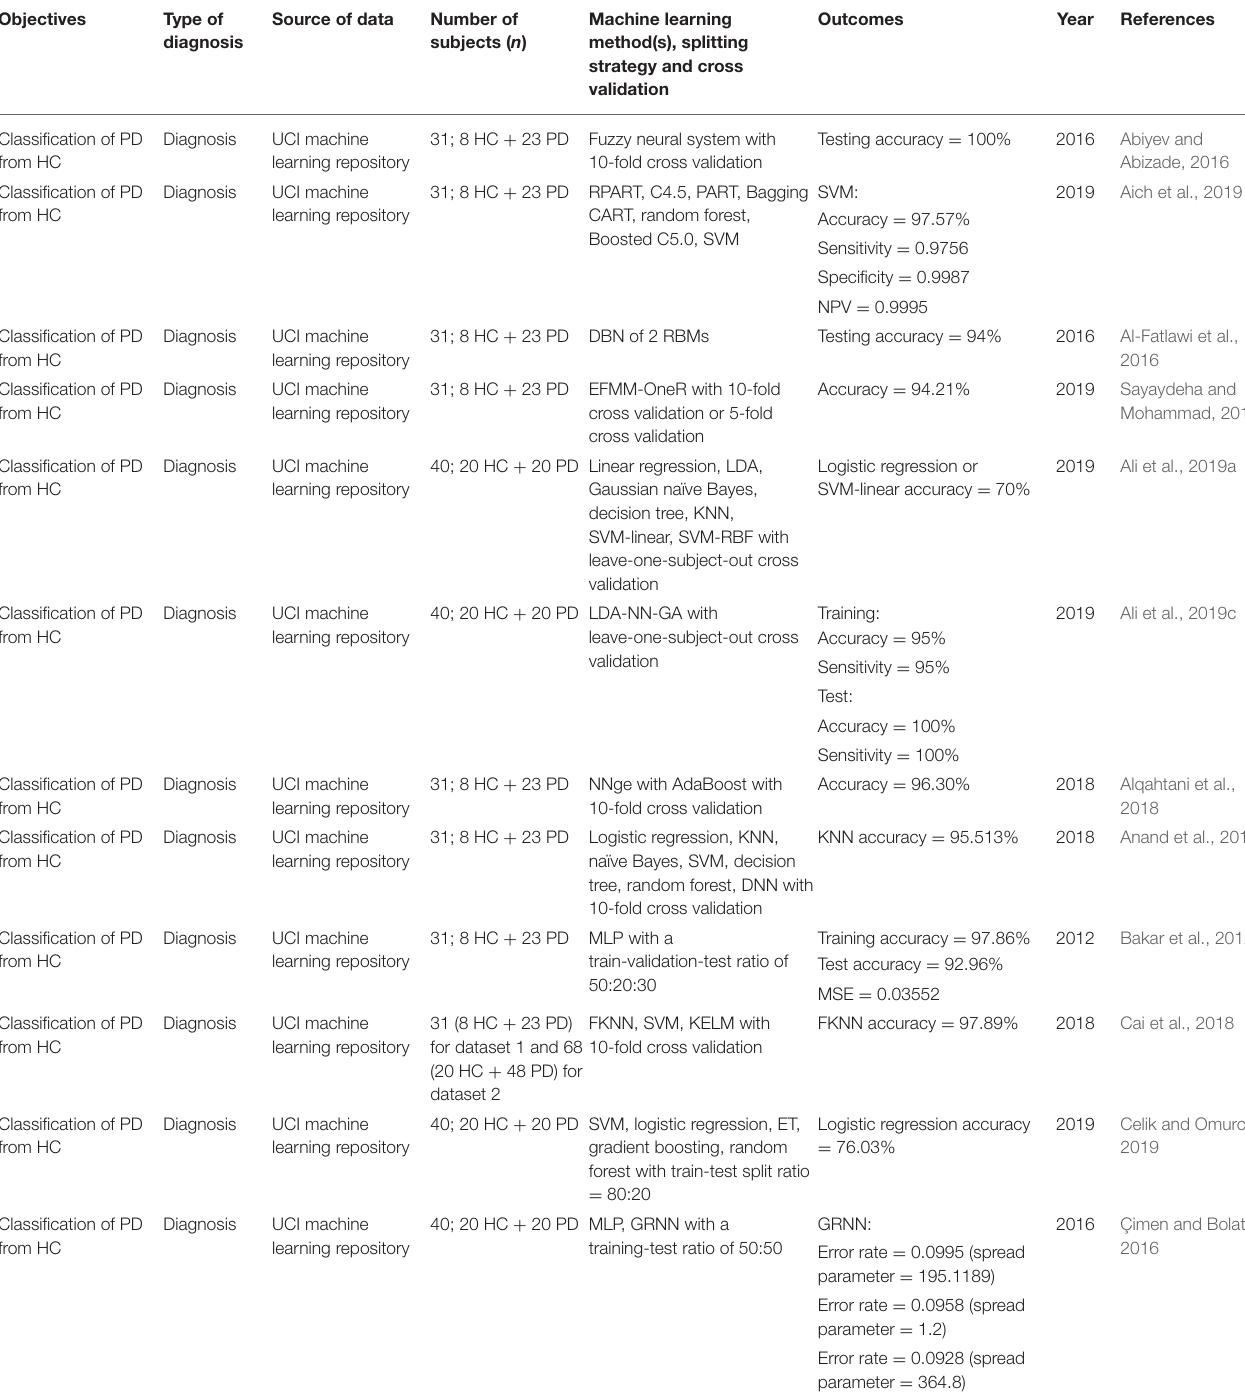
TABLE 4 | Studies that applied machine learning models to voice recordings to diagnose PD ( n